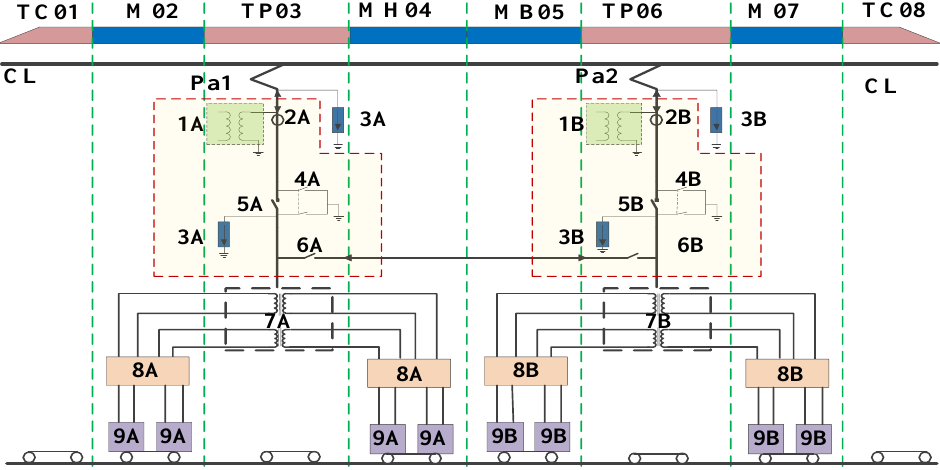
Figure 5. Equivalent model of the neutral zone (CL is contact wire, Pa1 is pantograph, 1A is voltage transformer, 2A is current transformer, 3A is arrester, 4A is earthing switch, 5A is breaker with operating voltage 25 kV and short-circuit current 25 kA, 6A is isolating switch, 7A is traction transformer, 8A is converter, 9A is traction motor, 1B–9B are the same devices as 1A–9A while they are spinning reserved).